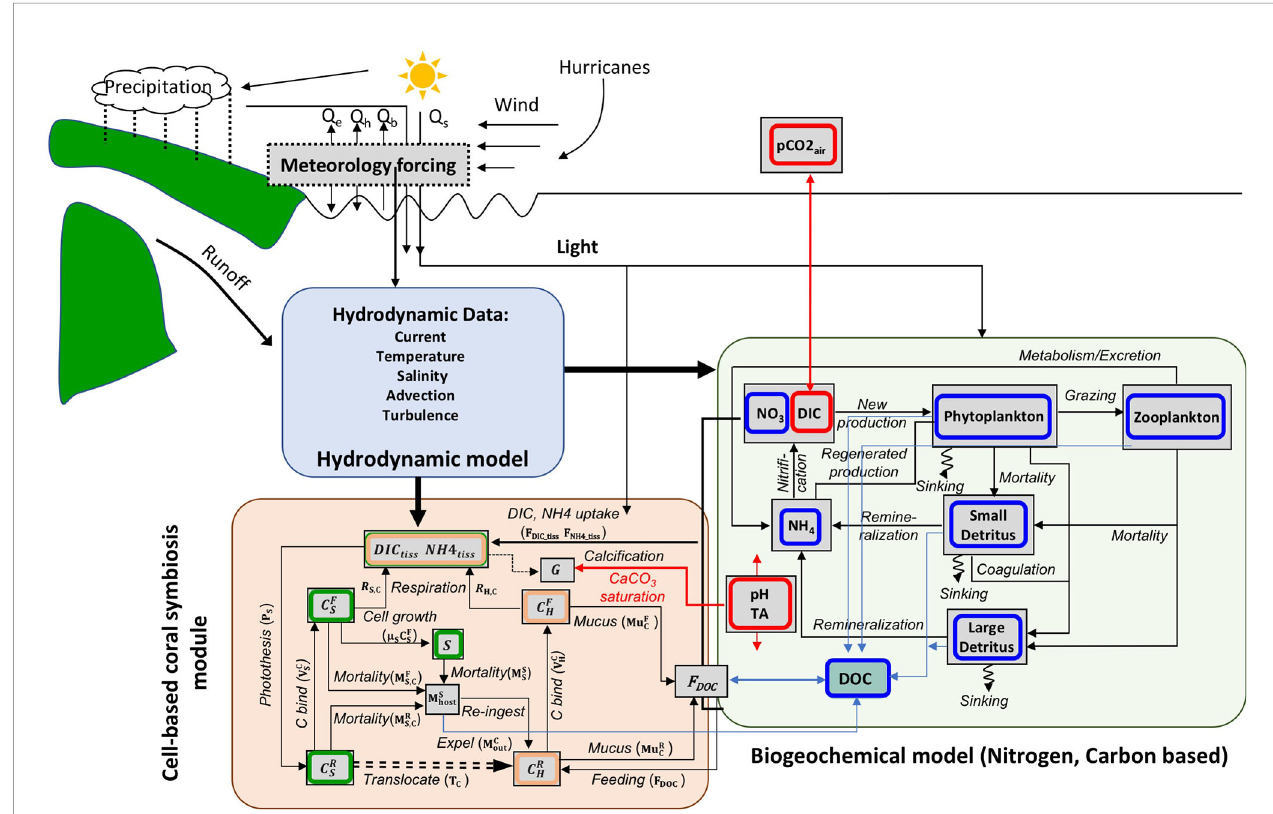
FIGURE 1 | Schematic showing the fl uxes of the coupled hydrodynamic, biogeochemical, and coral module. For the cell-base coral module, the symbols corresponding to these processes shown in Tables 3 , 4 are listed for